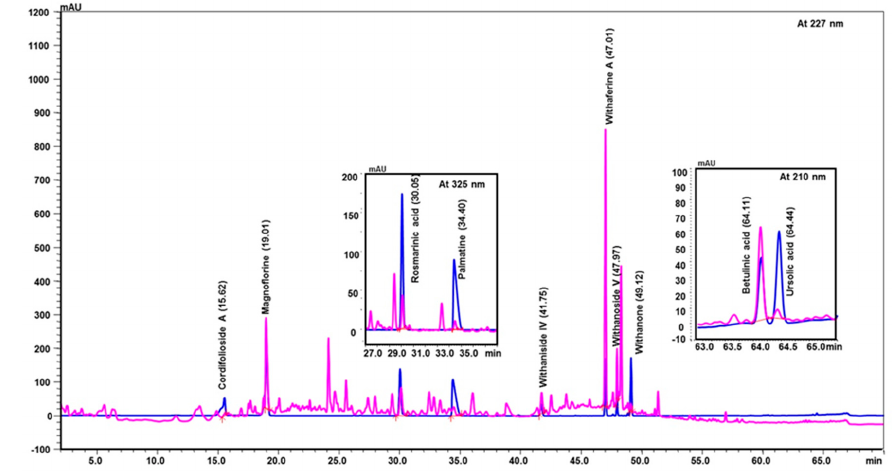
Figure 1. UHPLC analysis identified the presence of bio-active ingredients in Coronil. The Coronil sample (purple lines) was crushed into a fine powder and analyzed by UHPLC using reference standards mix (blue lines). The chromatographs were recorded at 210 nm (for betulinic acid and ursolic acid), 227 nm (for withanone, withaferine A, withanoside IV, withanoside V, cordifolioside A and magnoflorine), and 325 nm (for rosmarinic acid and palmatine) wavelengths. The chemical structures of these identified compounds, retention time (in minutes), concentration ( µ g / mg) and the plant species it was derived from are given in Table